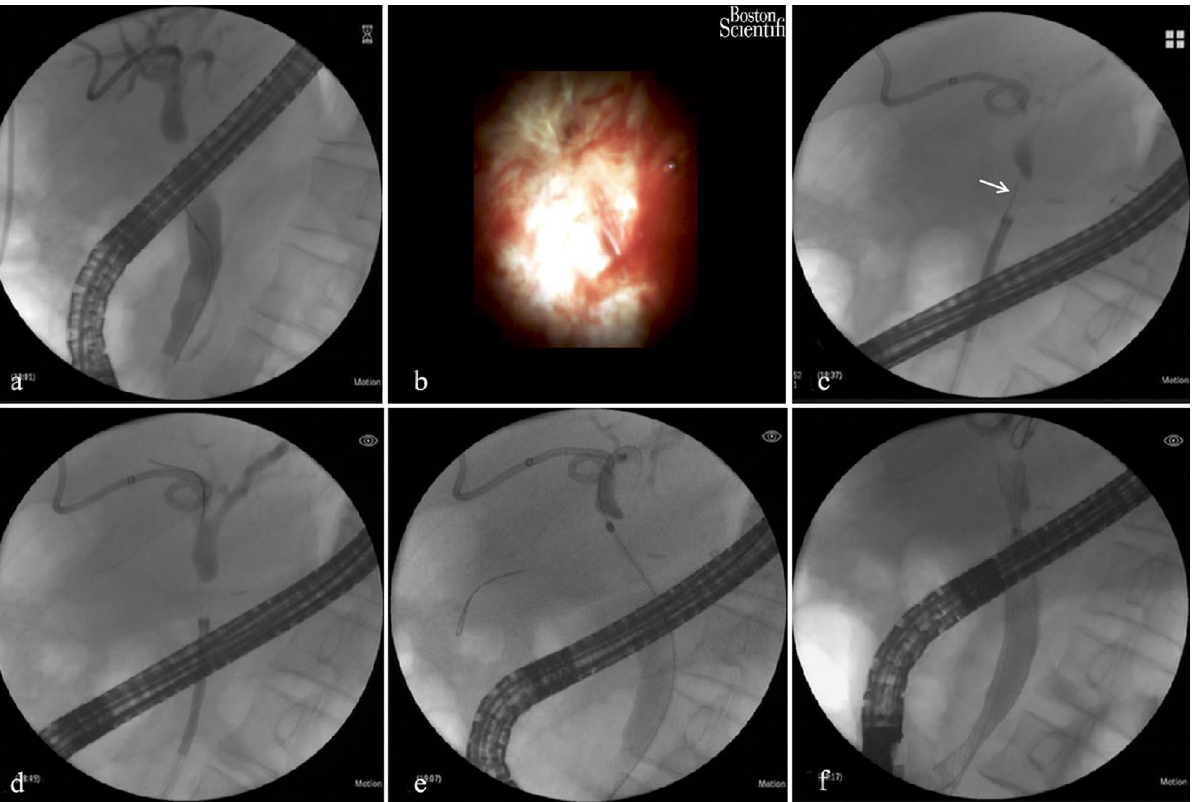
Figure 2. SpyGlass-assisted puncture of the complete biliary anastomotic strictures using the hard tip of the guidewire. ( a ) The stricture is impassable by conventional ERCP methods. The cholangiography, which is performed though PTCD and ERCP at the same time, implies two disconnected stumps. ( b ) The stricture is completely occlusive under SpyGlass. ( c ) Hard-tip (arrow) puncture of the stricture is performed under guidance of both SpyGlass and fluoroscopy. ( d ) Recanalization is successful, as indicated by the visible graft duct. ( e ) The stricture is expanded with 8 Fr dilating bougie. ( f ) A fully covered self-expanding metallic stent is deployed over the